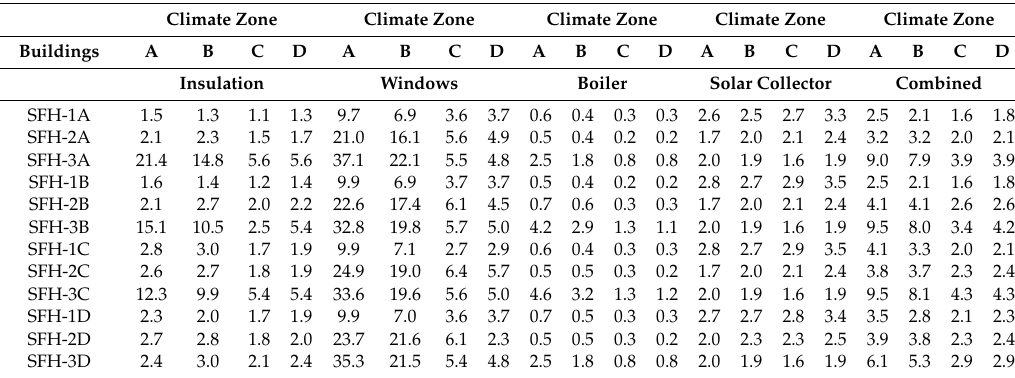
Table 5. Energy recovery time (years) for individual energy conservation and e ffi ciency measures and a combined scenario for the di ff erent case